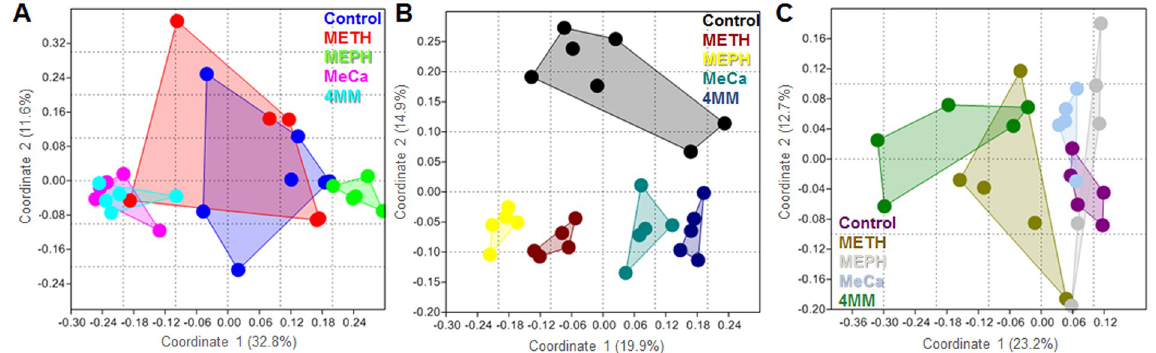
Fig 2. Effects of study drugs on β -diversity. Principal Coordinates Analyses (PCoA) illustrating differences in the structure (i.e. Bray-Curtis index) of gut microbiome profiles among mice treated with the different study drugs. Profiles were generated at 1 (A), 2 (B) or 7 days (C) after drug